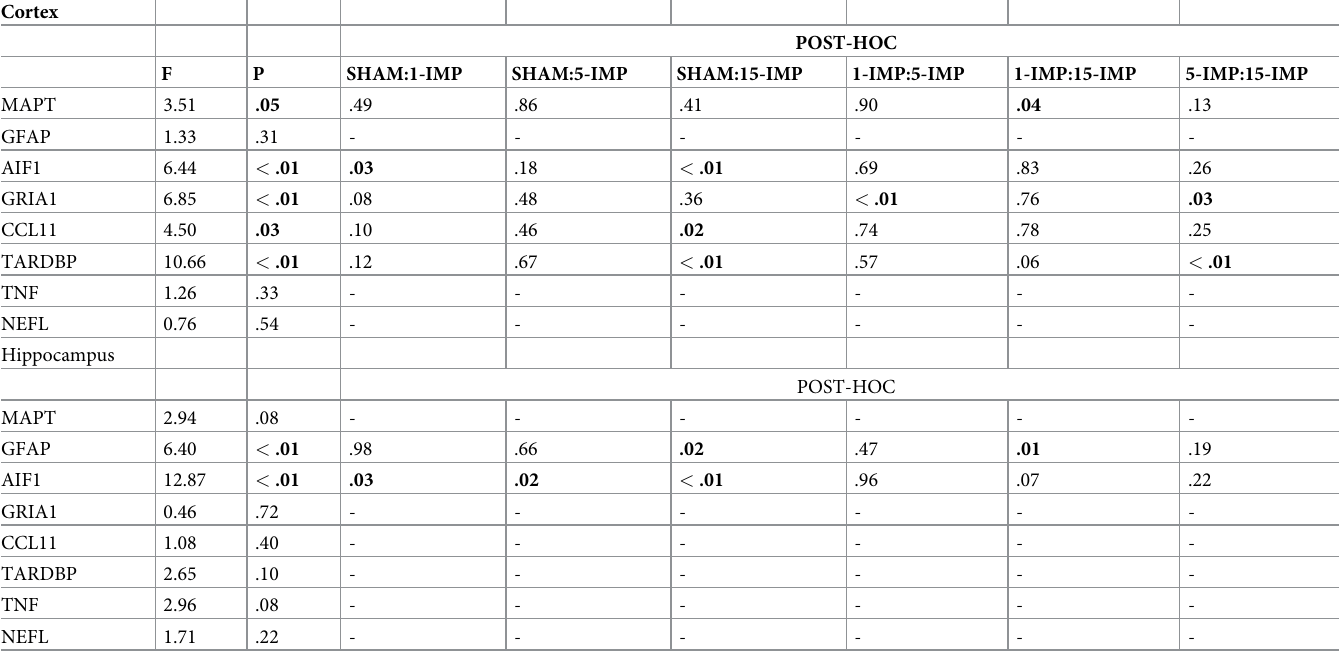
Significant differences p < .05 are in bold.